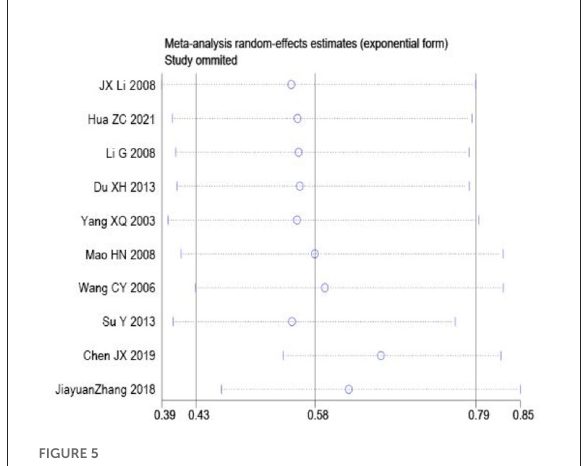
FIGURE5 Sensitivity analysis of depression indicators.